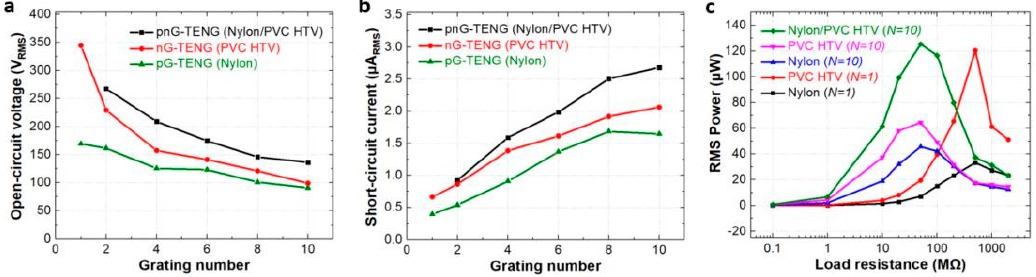
Figure 3. ( a ) V OC , ( b ) I SC and ( c ) P for different triboelectric nanogenerators (TENGs) and different grating